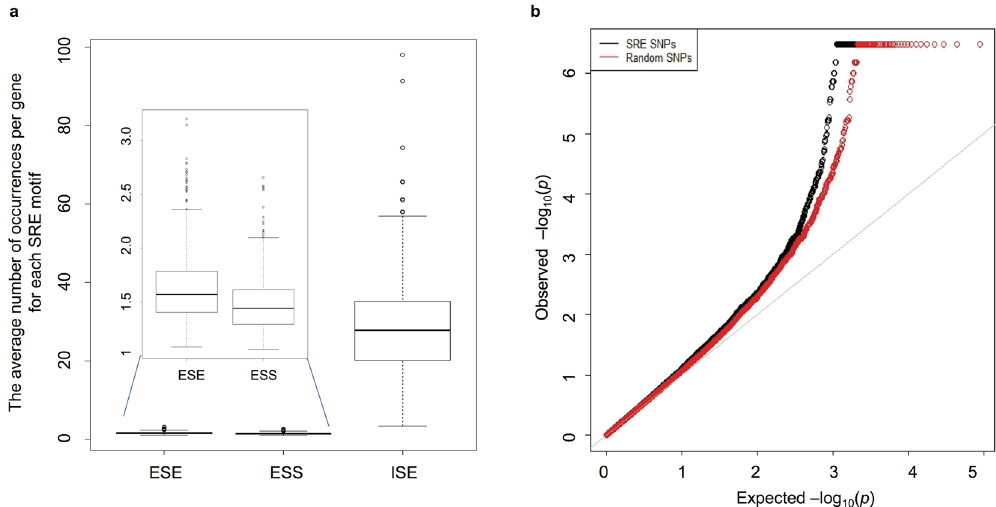
Figure 1. SRE SNPs: distribution of SRE motifs and evidence of impact on splicing. ( a ) The box plot shows the distribution of the number of occurrences per gene for each class of SRE motifs. ( b ) The Q-Q plot shows the distribution of p-values from the association with splicing ratios of genes (estimated using sQTLseekeR applied to GTEx first-phase data) in whole blood for the set of SRE SNPs and for a random set of SNPs matched on relevant SNP attributes. The leftward shift in the Q-Q plot was observed for the SRE SNPs relative to all such random sets (n = 1000).